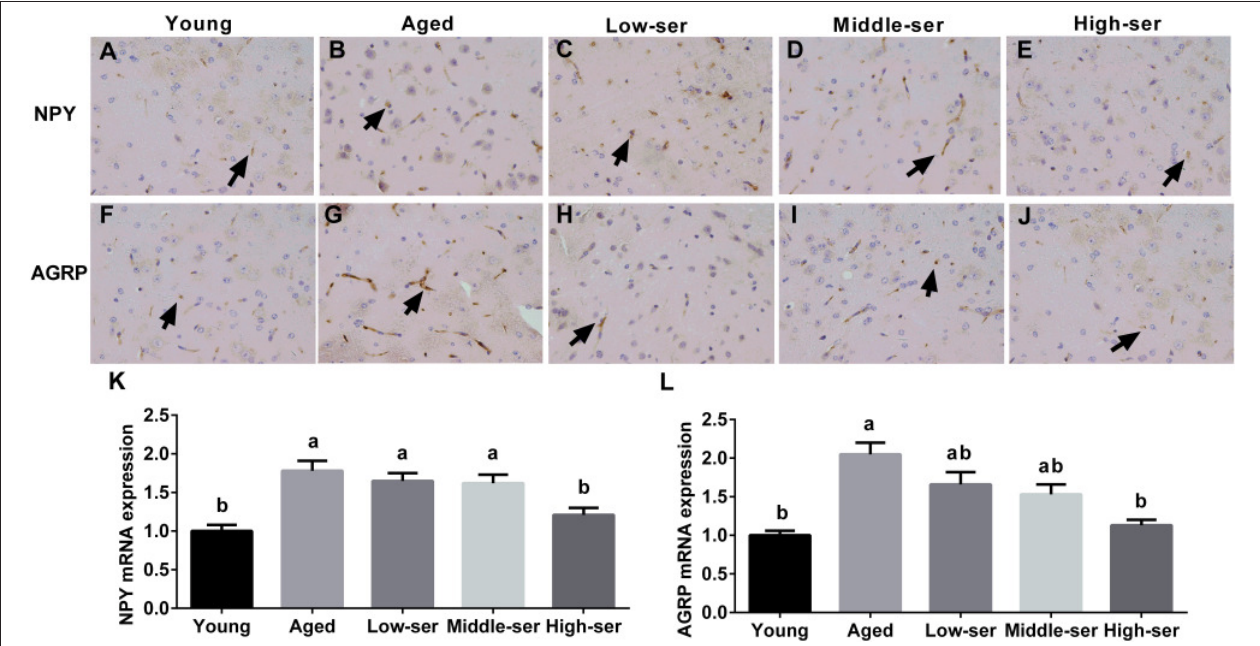
FIGURE 5 | Effects of long-term L -serine administration on orexigenic neuropeptide expression in aging mice. NPY (A–E) and AGRP (F–J) expression as determined by immunohistochemistry; relative NPY (K) and AGRP (L) mRNA expression. Aged, untreated control mice; Low-ser, mice supplemented with 0.1% (wt/vol) L -serine dissolved in the drinking water; Middle-ser, mice supplemented with 0.2% (wt/vol) L -serine dissolved in the drinking water; High-ser, mice supplemented with 0.5% (wt/vol) L -serine dissolved in the drinking water. Young, adult male mice at the age of 18 months. Arrow (yellow), expression of target proteins; NPY, neuropeptide Y; AGRP, agouti-related protein. Values are expressed as mean ± SEM, n = 8; a,b Means of the bars with different letters were significantly different among groups ( P <